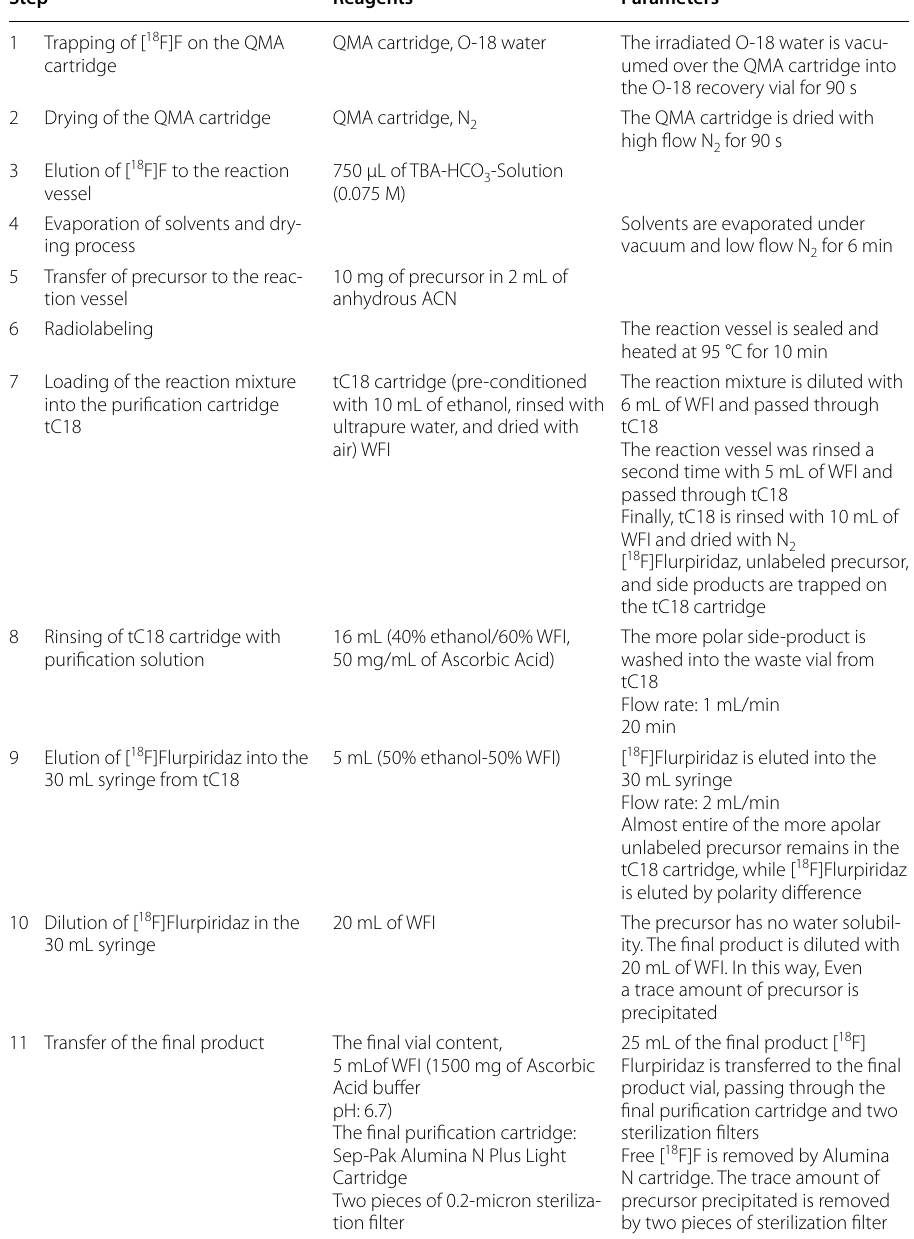
Table 1 Radiosynthesis steps of [ 18 F]Flurpiridaz ( 7